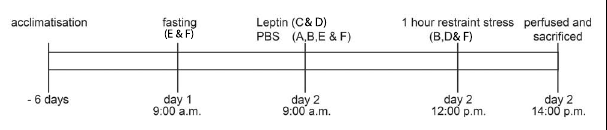
FIGURE 1 |Timeline showing the animal handling and exposure to the various experimental treatments. The experiment started on day 1. Letters between brackets indicate the experimental groups (A: PBS + no stress; B: PBS + stress; C: Leptin + no stress; D: Leptin + stress; E: Fasting + no stress; F: Fasting +